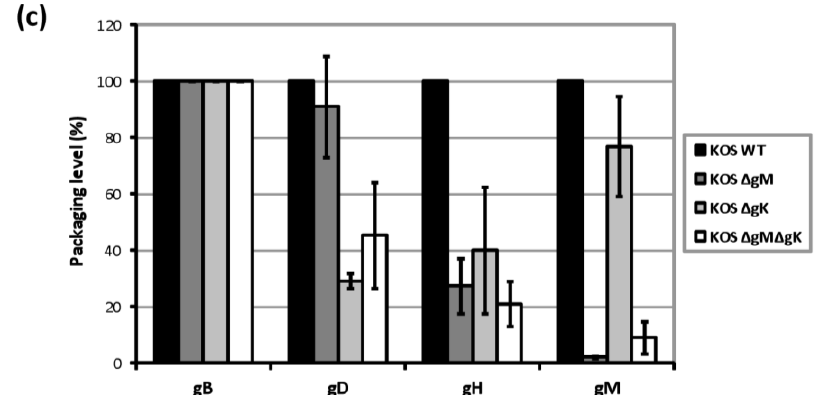
Figure 6. Viral protein incorporation in WT, ΔgM, ΔgK and ΔgMΔgK virions. HaCaT cells were infected at 5 PFU/cell and after 24 hpi, ( a ) cell lysates were prepared and ( b ) progeny viral particles were isolated from clarified cell culture media by centrifugation through a 33% sucrose cushion. Cell lysates and supernatant-derived virions were separated by SDS-PAGE and analysed using the indicated antibodies. Molecular mass markers (in kDa) are indicated on the right; ( c ) Using densitometry, packaging levels were calculated by dividing the amount of protein detected in supernatant-derived virions (normalized for gB) by the amount of protein in supernatant-derived virions of WT virus (normalized for gB). Error bars represent standard error of three independent